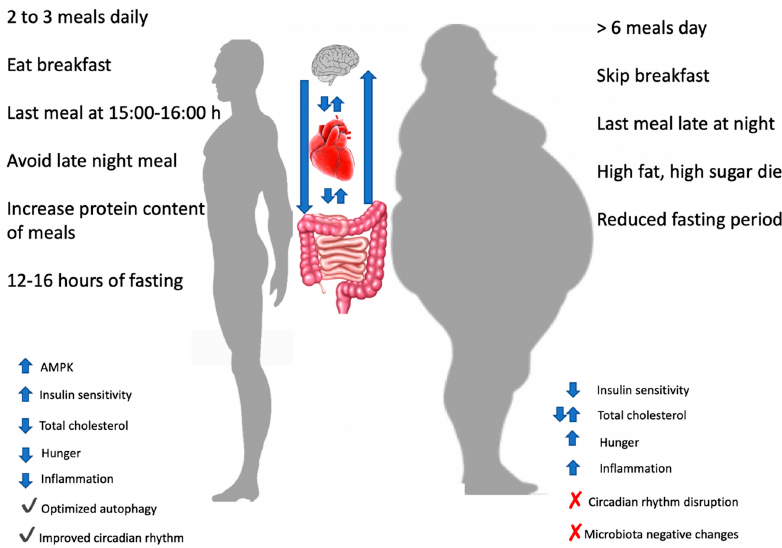
Figure 3. Effects of different meals timing and frequency on different variables. At the centre of the picture the reciprocal influences of brain, heart and gut was showed. AMPK: AMP-activated protein kinase.